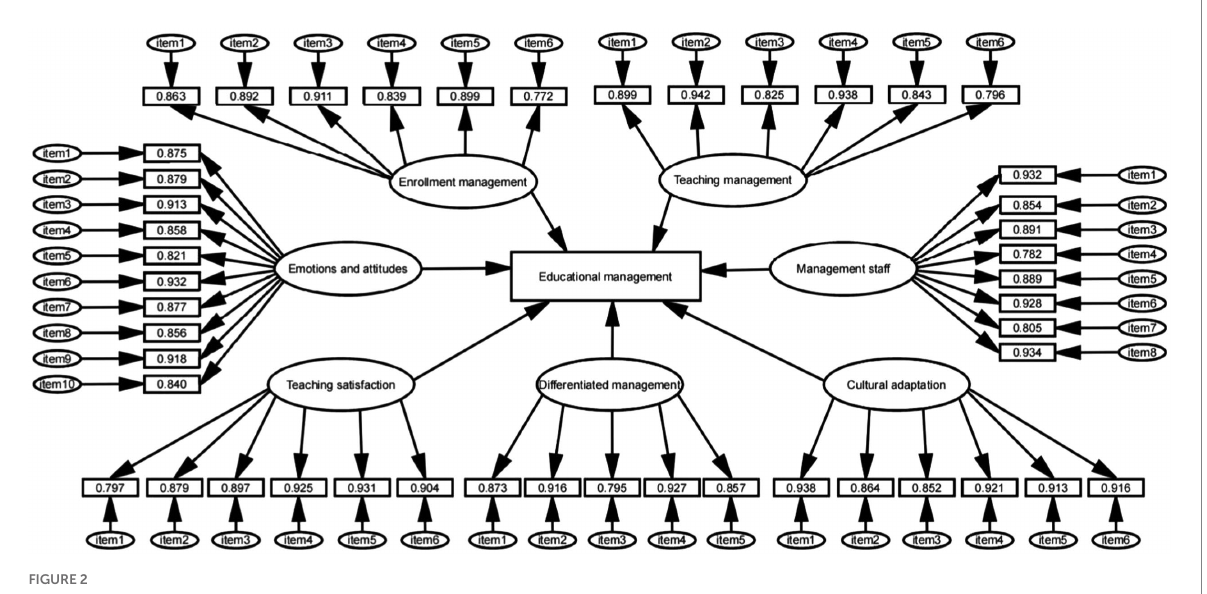
FIGURE 2 Educational management measurement